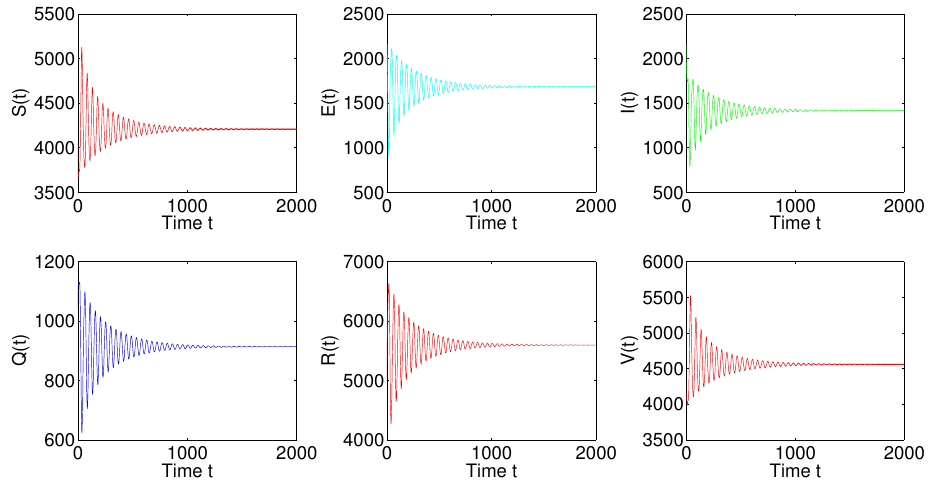
Figure 1. Time plots of S , E , I , Q , R and V with τ = 12.85 < τ 0 = 13.1047.